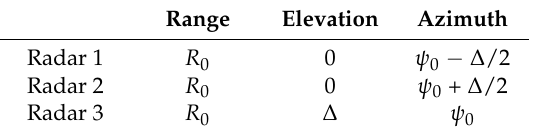
Figure 4. Evaluation of the normalized location accuracy, Dilution of Precision (DOP), for the case of three equally displaced Radars. ( a ) Geometry. ( b ) DOP measured for different direction of the target deformation, with regard to the Radars placed in correspondence of the star markers. The Radar angular separation is Δ = 30°. ( c ) Same as (a,b), but assuming a system made only by two Radars. Table 1. Radar locations in the target-centered reference in polar